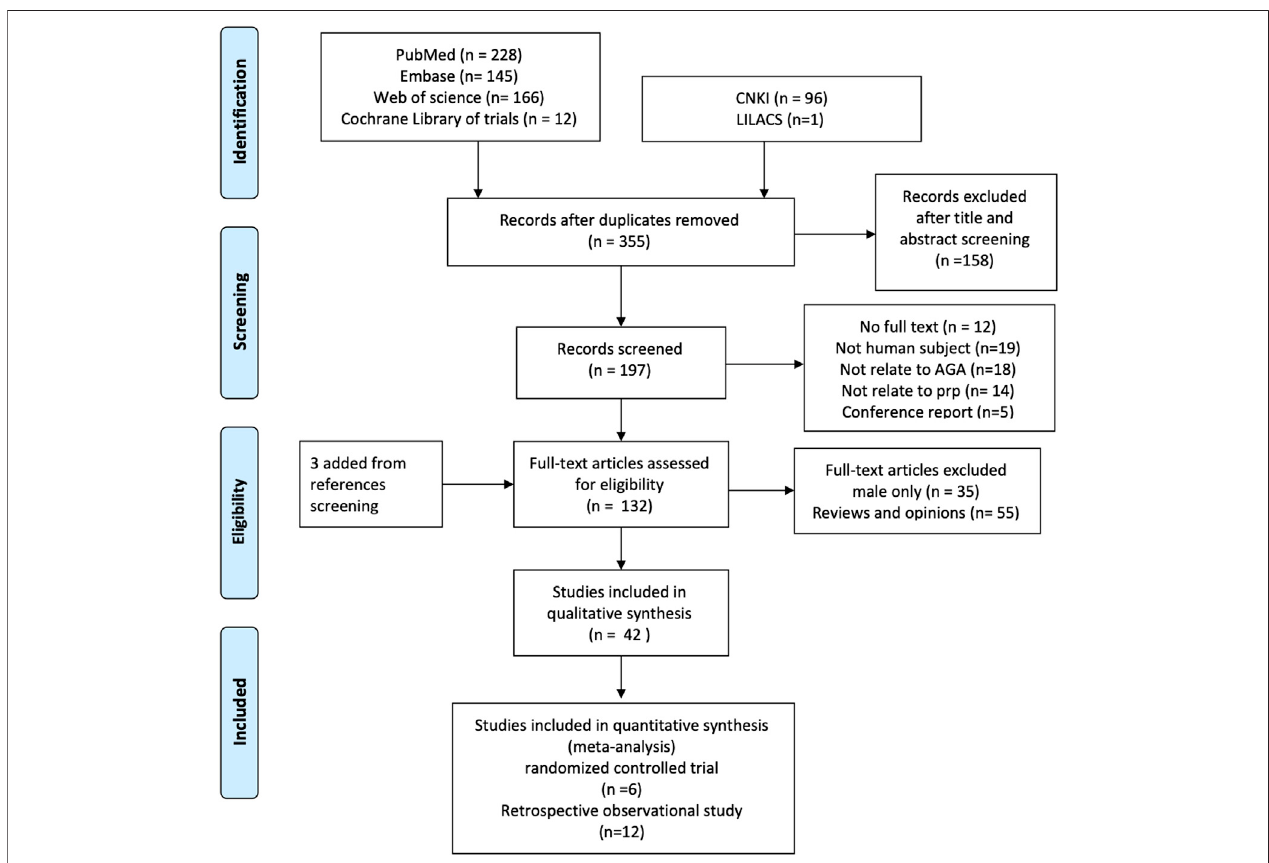
FIGURE 1 | The process of literature